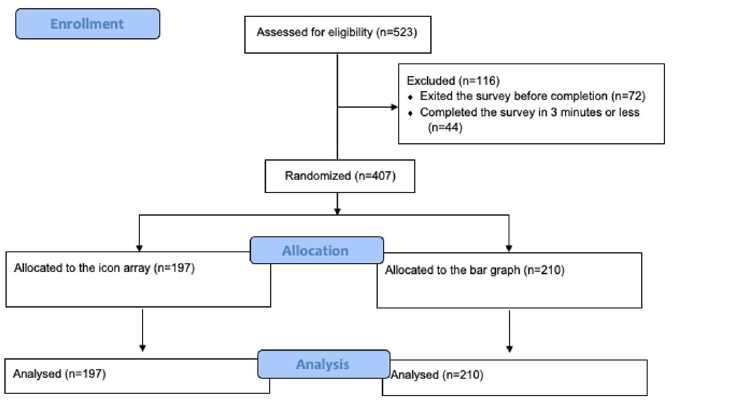
Fig 1. Flow diagram of the study